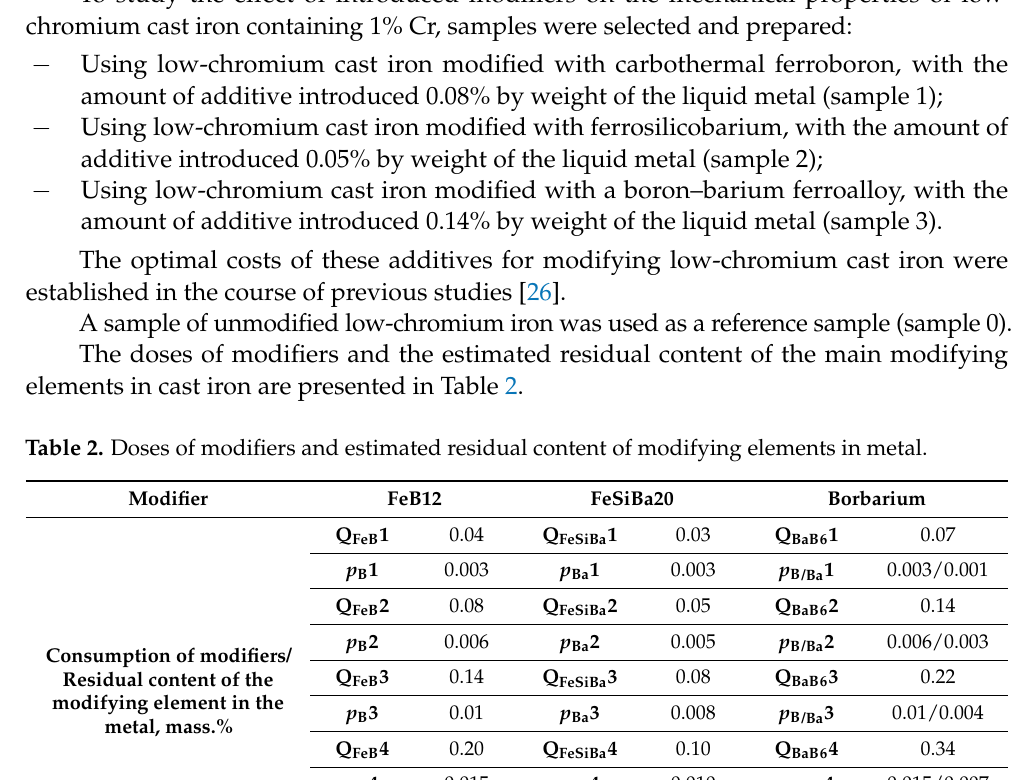
Consumption of modifiers/ Residual content of